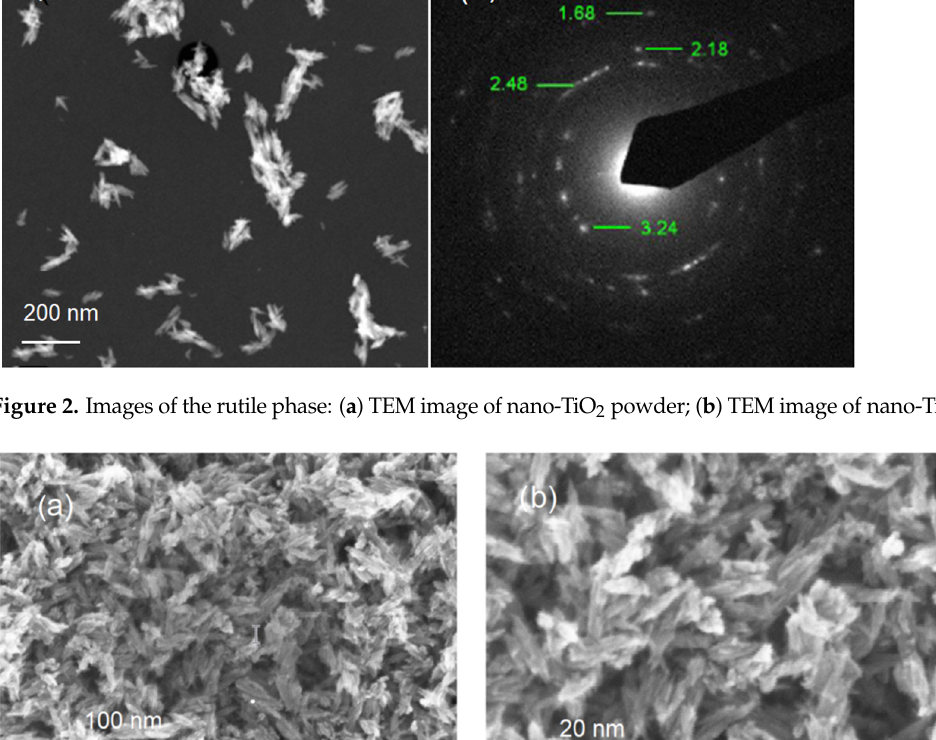
Figure 3. Images of FE scanning electron microscopy: ( a ) scale bar = 100 nm; ( b ) scale bar = 20 nm.